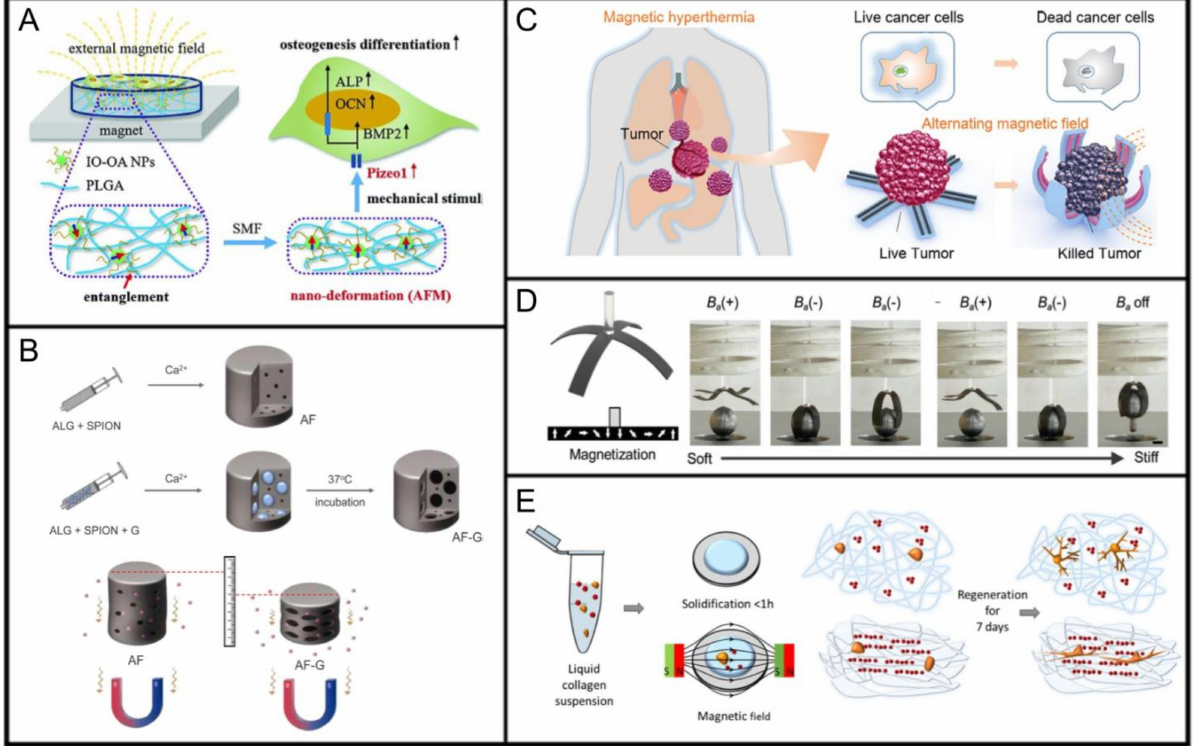
Figure 5. Bioengineering applications of magneto-active polymers in: ( A ) bone tissue engineering: mechanical stimulation based on the deformation of a magnetic composite leads to enhanced osteogenic differentiation (adapted with permission from [193]); ( B ) drug delivery: alginate ferrogel deformation by application of a magnetic field leads to controlled drug release (adapted with permission from [191]); ( C ) hyperthermia treatment: application of a magnetic ferrogel (PNIPAm- Fe 3 O 4 ) for tumour encasing and hyperthermia cancer therapy (adapted with permission from [144]); ( D ) soft robotics (adapted with permission from [190]); ( E ) neuronal regeneration: remote magnetic orientation of collagen fibres in a hydrogel for directed neuronal regeneration (adapted with permission from